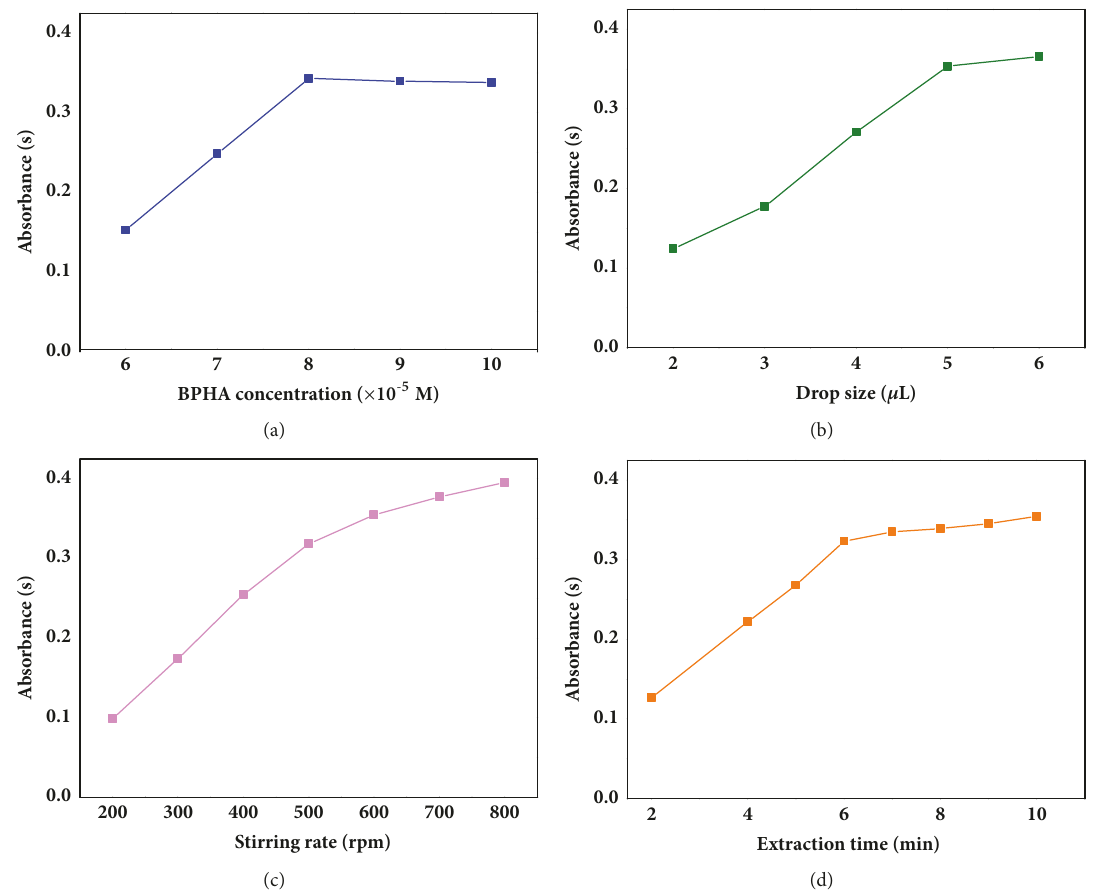
Figure 3: (a) The atomic absorbance of Sb (III) in solutions with the concentration of BPHA from 6 × 10 −5 M to 10 × 10 −5 M. (b) The atomic absorbance of Sb (III) in solutions with the drop size from 2.0 to 6.0 𝜇 L. (c) The atomic absorbance of Sb (III) in solutions with the stirring rate from 200 to 800 rpm. (d) The atomic absorbance of Sb (III) in solutions with the extraction time from 2 to 10 min.